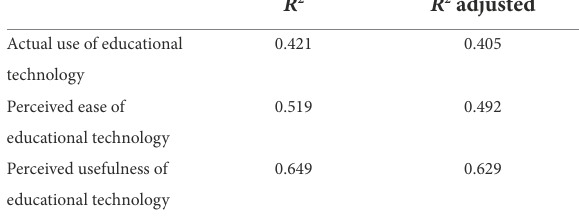
TABLE 8 Goodness of